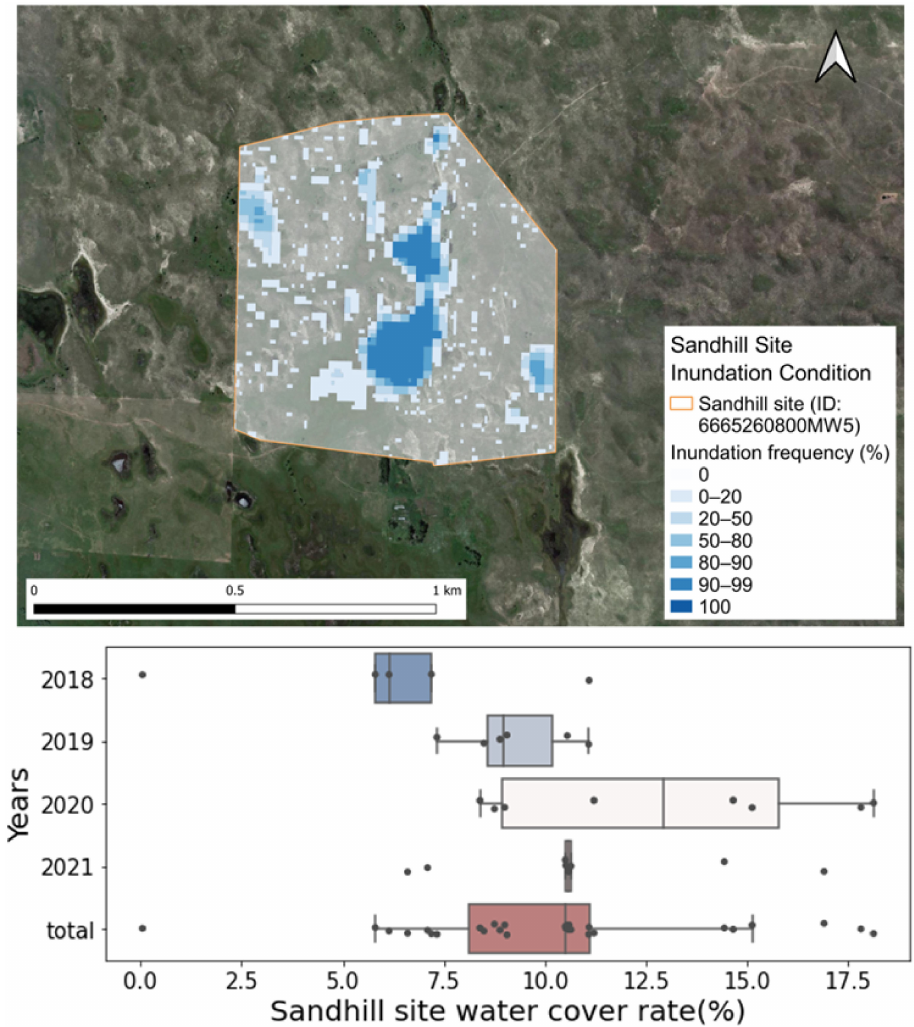
Figure 7. Inundation frequency and surface water cover rate in the sandhill site. The riverine site was also located in the Rainwater Basin, the location, and inundation frequency are shown in Figure 9. Data were not observed in May for all four years because of the climatic conditions and cloud coverage. The highest inundation frequency (100%) covered approximately 0.64% of the land at this site, while no inundation was observed over 85.69% of the site during the four years. The mean water cover rate was 2.35% according to the data for 25 months. The highest water cover rate was recorded in July 2020 (12.54%), while the lowest water cover rate was 0.80% in April 2020. The riverine site is located near Aurora, Nebraska. Changes in water coverage were very smooth at this site. Riverine wetlands are closely associated with floodplains. The inundation frequency map shows that water ponds occur year-round. However, surface water only appeared in a very limited area at this site. The mean surface water cover rate was very stable for the four years. The monthly surface water cover rate was mostly between 1 and 3%, while the yearly surface water cover rate showed little difference from the highest of 3.03% (2020) to the lowest of 1.68%